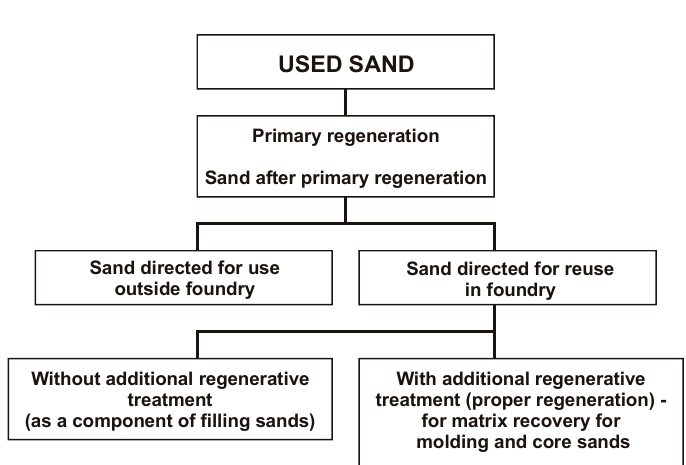
Figure A1. Management methods for used molding sands—developed on the basis of [3].